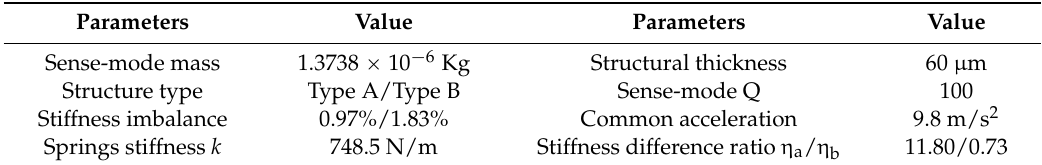
Table 1. Model parameters used in the simulation models.